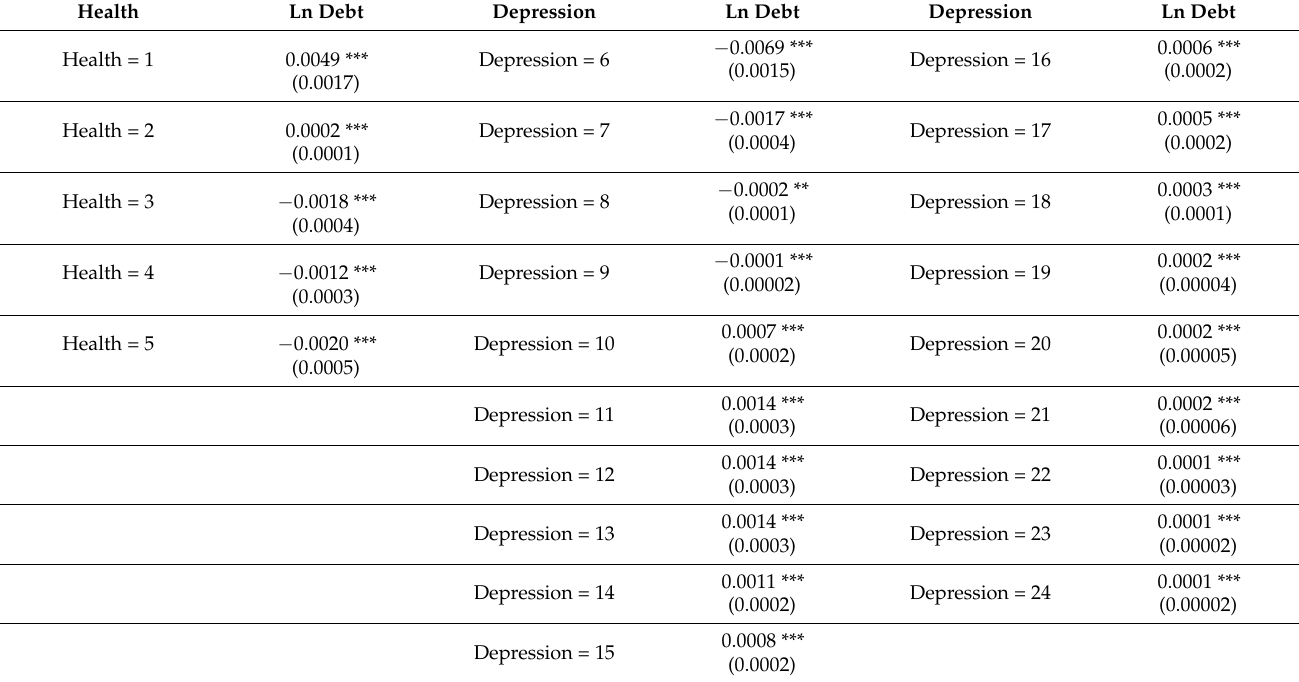
Table A7. Marginal effects of household debt in middle income subgroup.